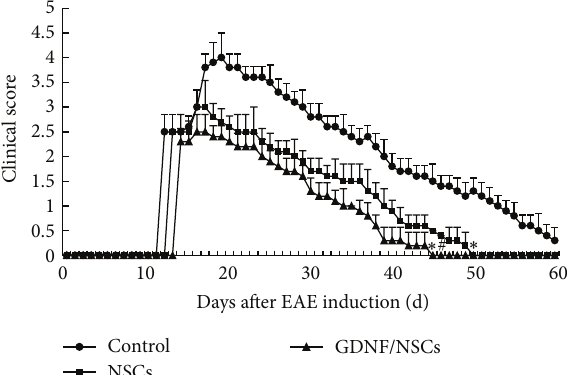
Figure 2: The improvement of clinical symptoms after transplantation (mean ± SD, 𝑛 = 5 ). ∗ Comparison with control group, 𝑃 < 0.05 ; # comparison with NSCs group, 𝑃 < 0.05